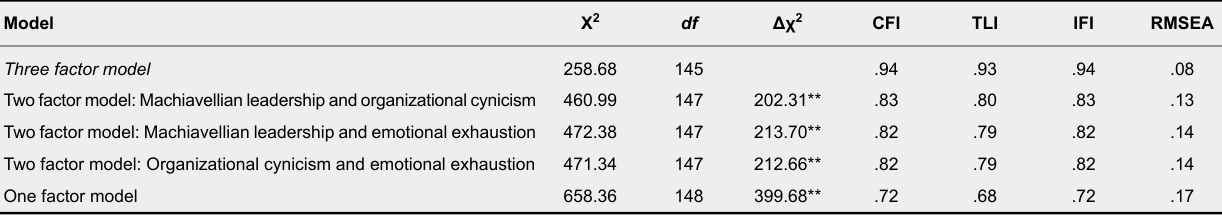
Confirmatory Factor